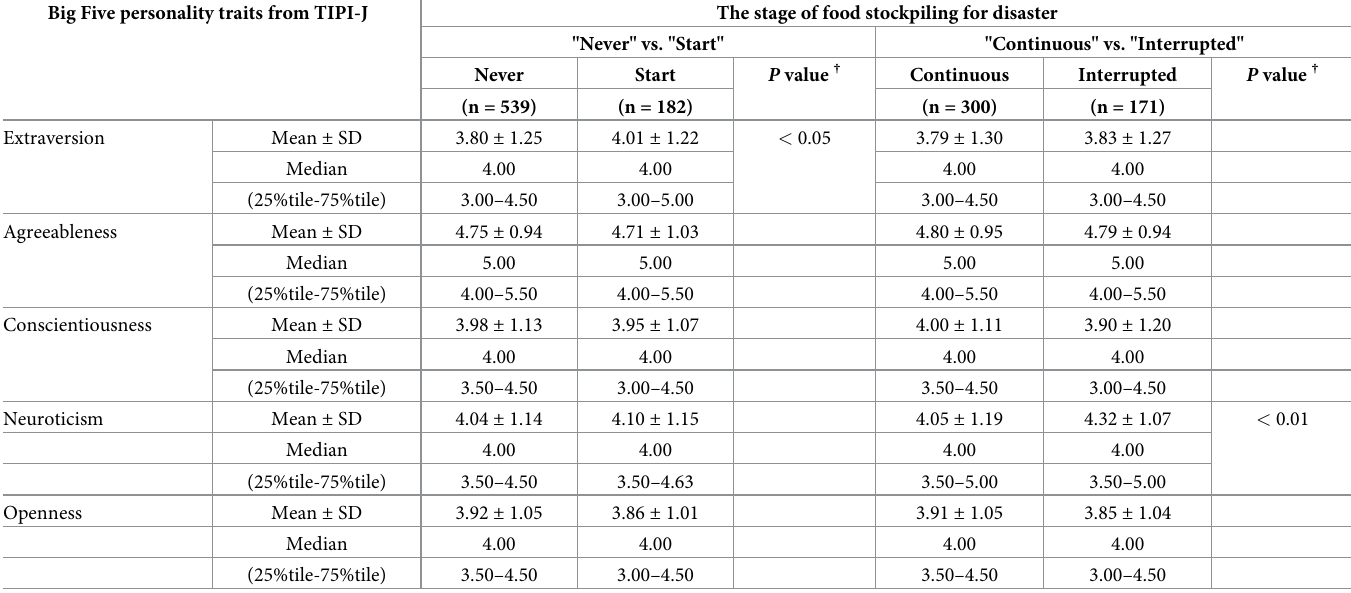
Table 4. The distribution of the Big Five personality traits by food stockpiling stage. Big Five personality traits from TIPI-J